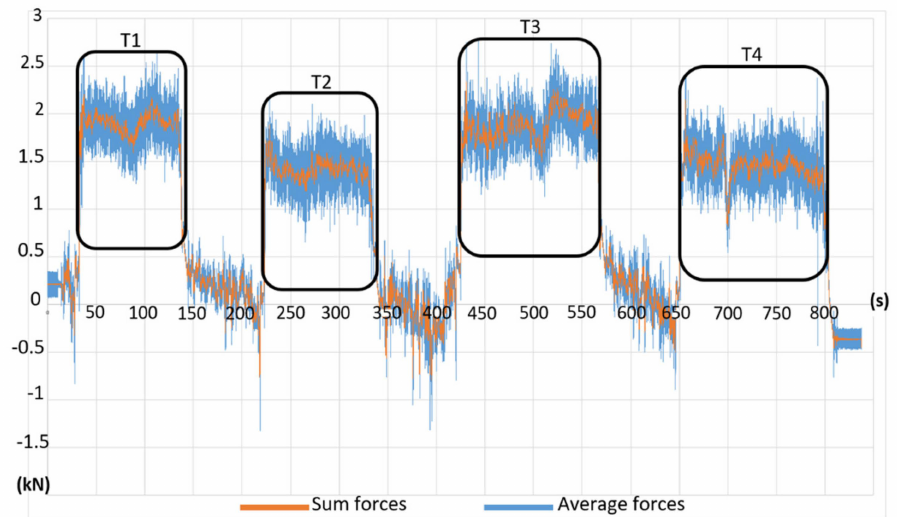
Figure 7. Plotted average horizontal force during the seeding operation. Vertical axis represents the forces (kN) and horizontal axis shows the time (s).